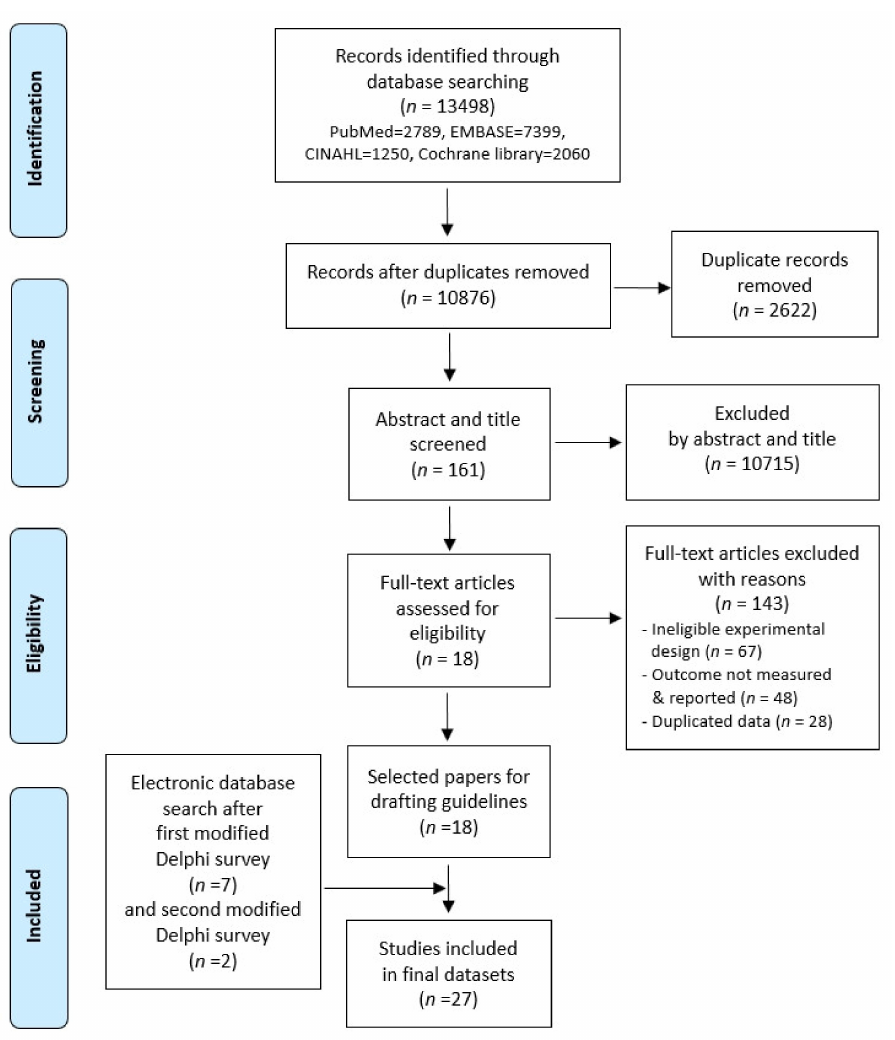
Figure 1. Flow diagram showing the literature inclusion and exclusion criteria in the Preferred Reporting Items for Systematic Reviews and Meta-Analyses (PRISMA)